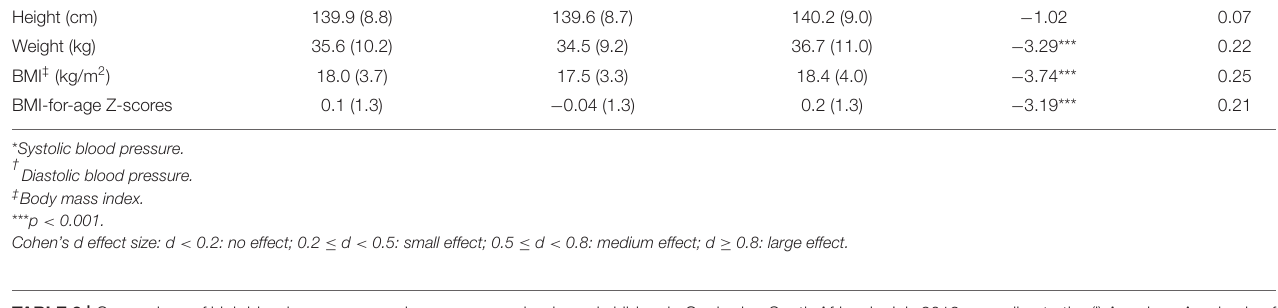
TABLE 2 | Comparison of high blood pressure prevalence among school-aged children in Gqeberha, South Africa, in July 2019 according to the (i) American Academic of Pediatrics, (ii) German guidelines, (iii) a global reference population, and (iv) the KaziBantu study population ( N =